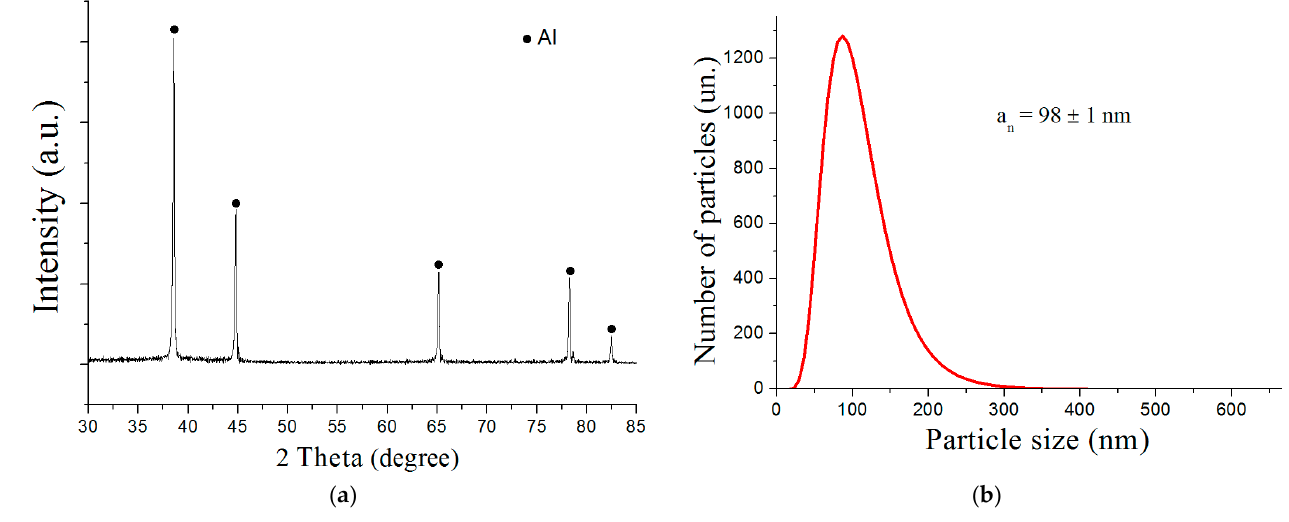
Figure 2. XRD pattern ( а ) and particle size distribution ( b ) of Al/Ag nanoparticles. The nanoparticles had a log-normal size distribution (Figure 2b) with the average particle size being 98